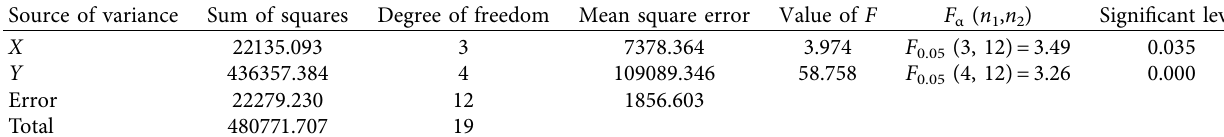
Table 6: ANOVA results of CUTB samples.